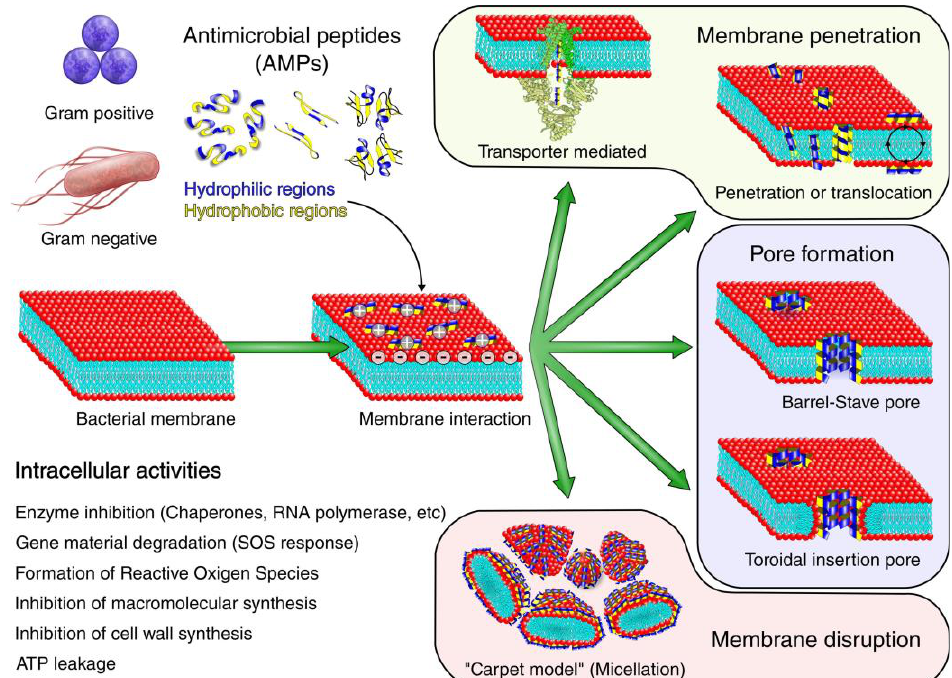
Figure 5. Diagrammatic sketch of the antimicrobial mechanisms of the antimicrobial peptides. Reprinted with permission from ref [108] 2017 Biochem. Pharmacol.